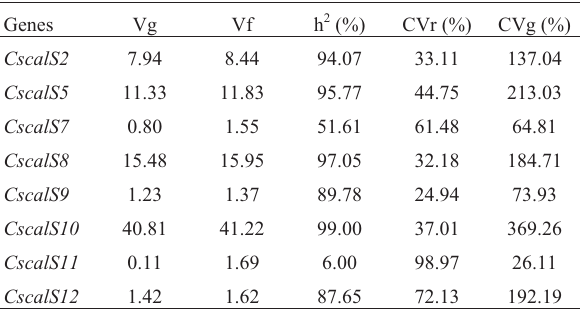
Table 3 - Estimates of genotypic and phenotypic variances, heritability and coefficients of variation for gene expression.